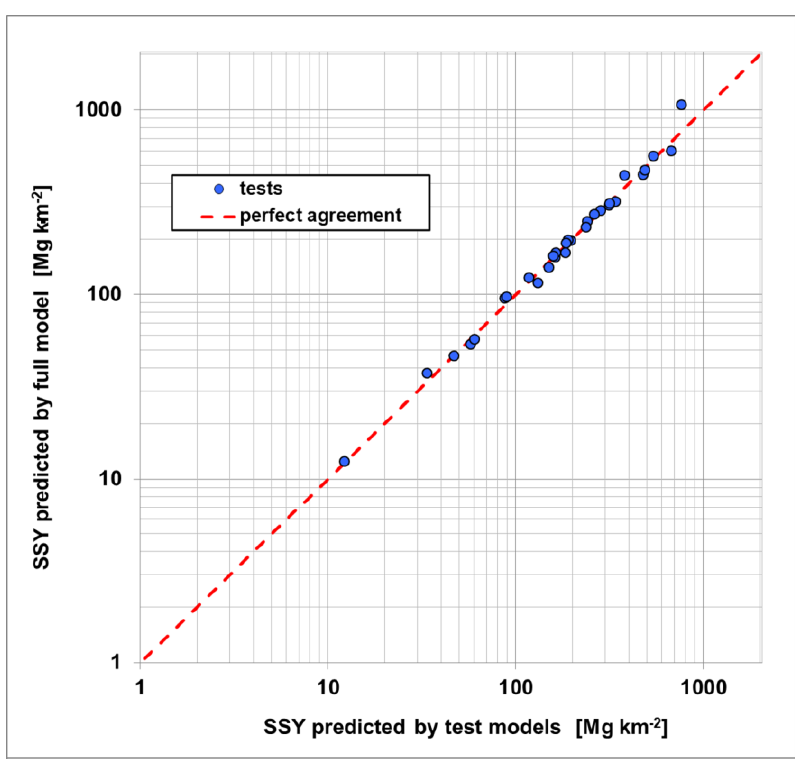
Figure 6. Results of the jackknife test models plotted vs full model Equation (2).